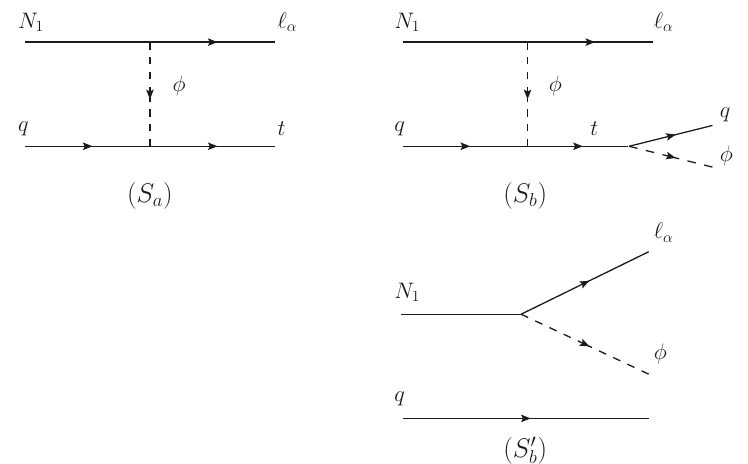
‘ (cid:11) t and N 1 q ‘ (cid:11) q(cid:30) , which should be ! ! (cid:0) (cid:1) (cid:21) 2 the process N 1 q ‘ (cid:11) q(cid:30) t O ! b